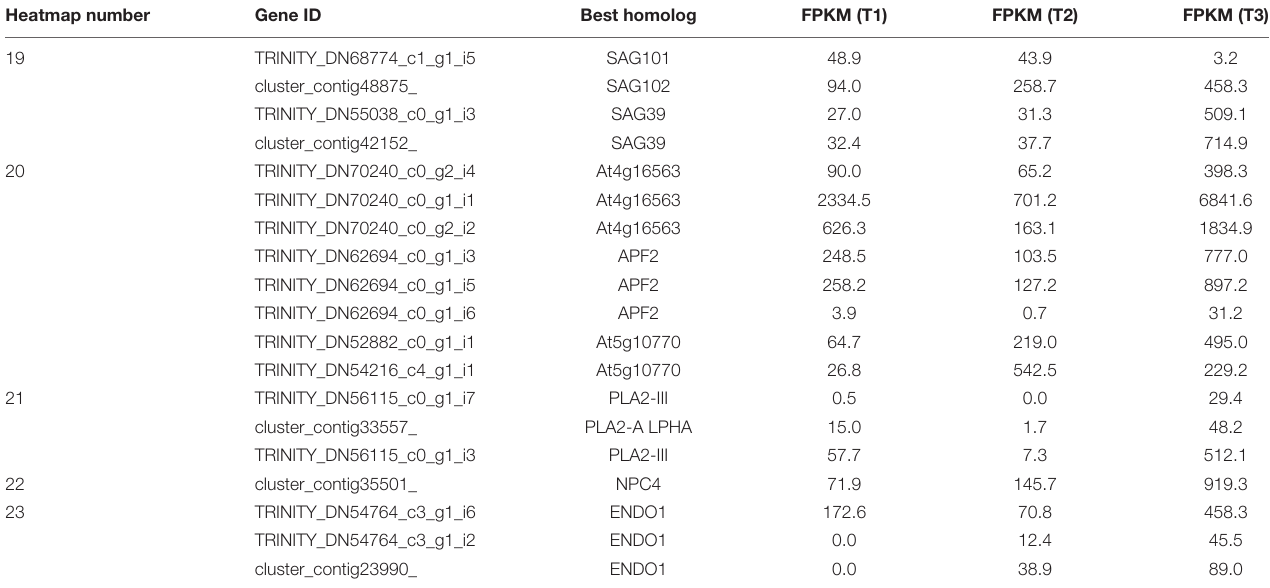
FIGURE 5 | Heatmap of components involved in cell metabolism in the three petal transcriptomes, T1, T2, and T3. (A) The expressed genes assigned to hydrolases. (B) The expressed genes assigned to water relation and cell wall modification (the corresponding genes are listed in Tables 3 , 4 according to the labeled number “19” to “30” in each map). Red and blue colors indicate upregulated and downregulated transcripts, respectively. TABLE 3 | Hydrolases (corresponding to Figure 5A